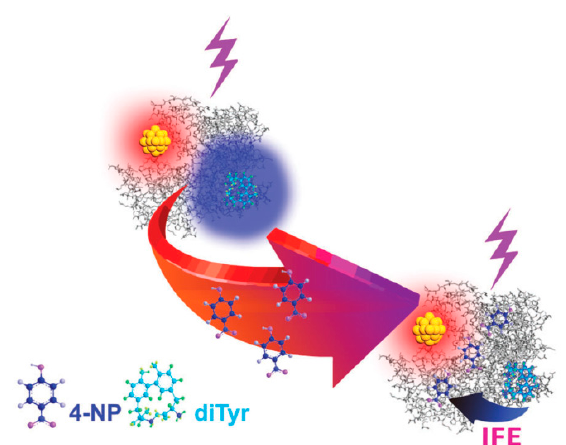
Figure 10. Schematic illustration of the 4-NP-induced selective quenching of the blue fluorescence emission of the diTyr residues of the GNCs@BSA via the inner filter effects (IFE). Adapted with permission from Reference [50] Copyright (2018) Royal Chemistry Society.